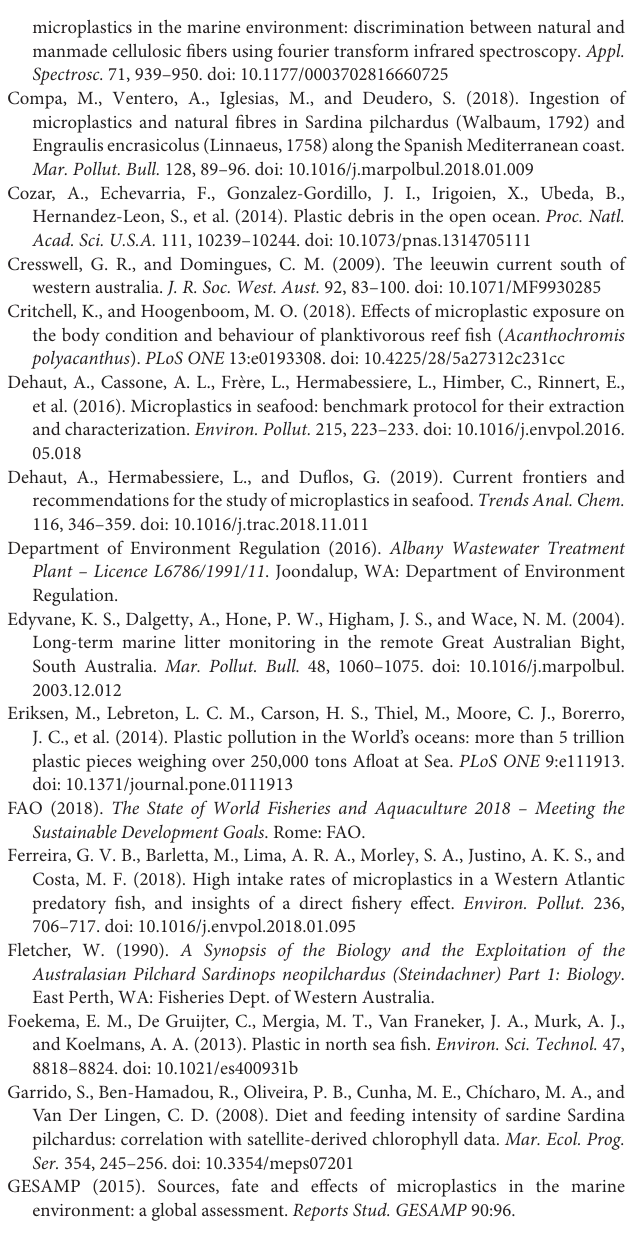
TABLE S1 | Criteria for each visually distinct particle group and the respective particle count for